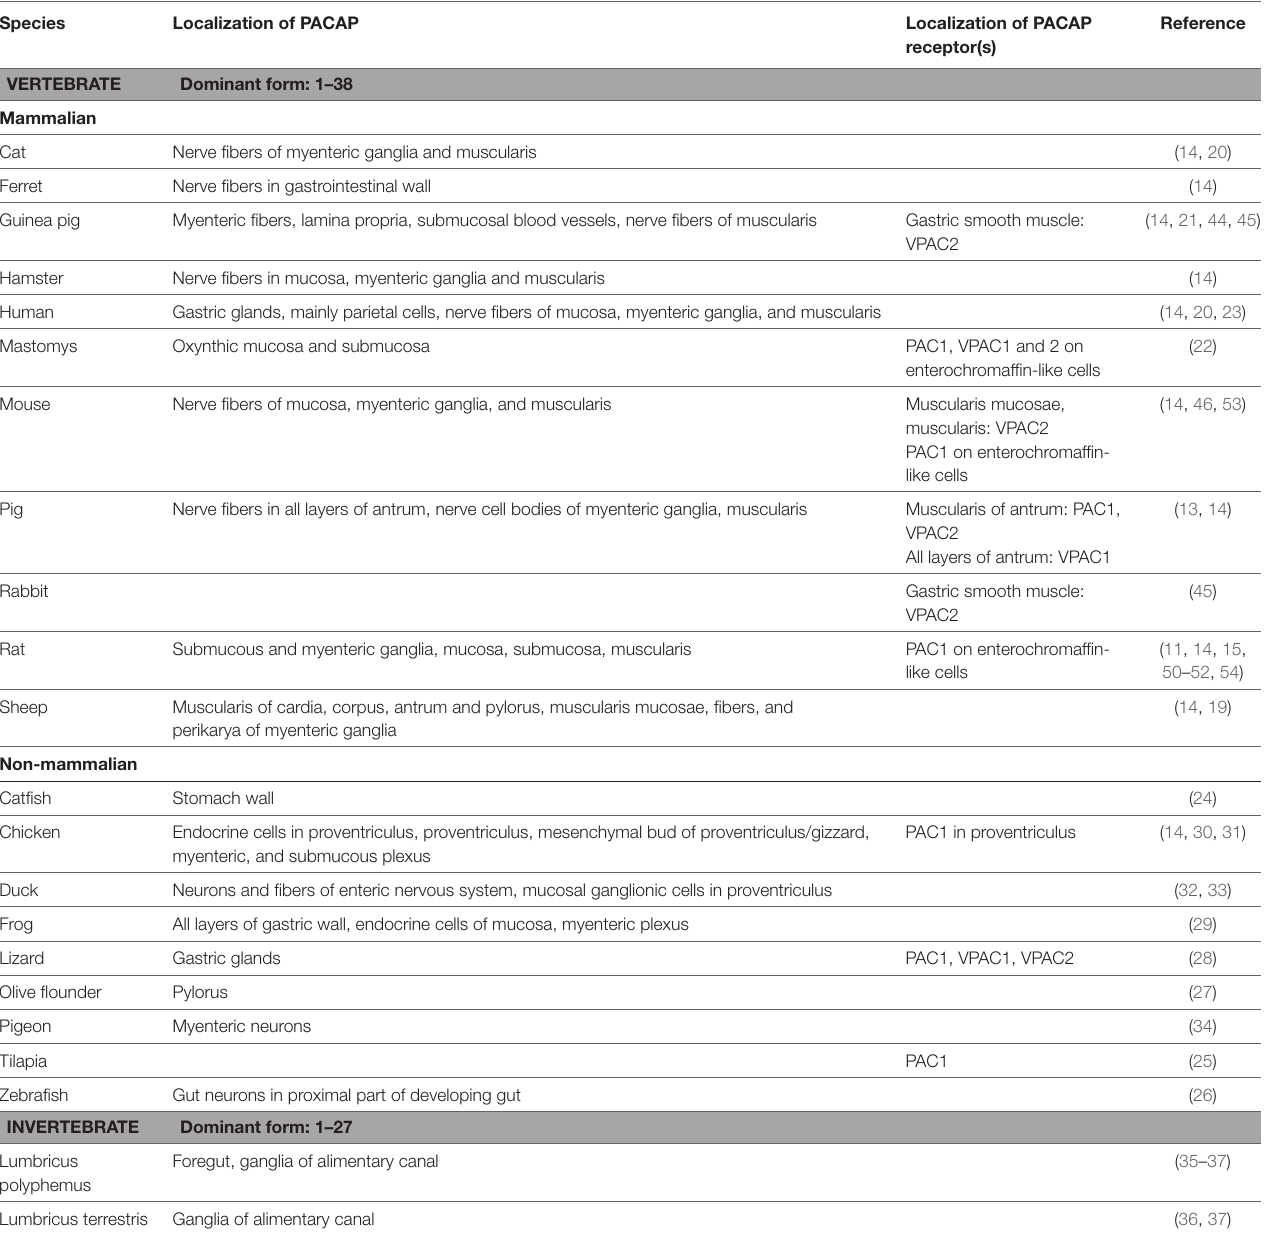
TABle 1 | Presence and main distribution sites of PACAP and its receptors in the stomach of various species.